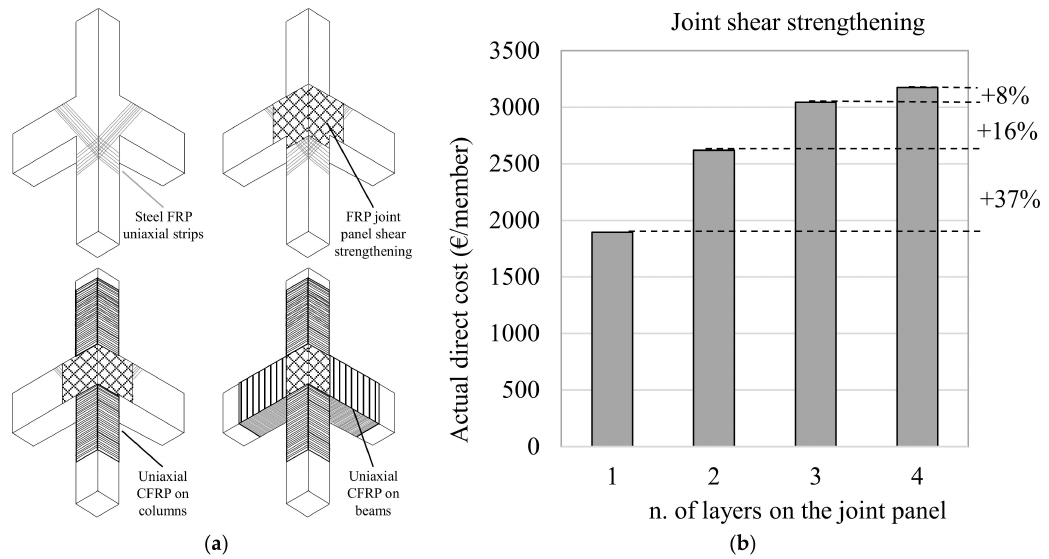
Figure 9. Fabrication steps of the joint subassembly FRP strengthening ( a ); direct cost of FRP shear strengthening of the beam-column joints as a function of the n. of layers applied to the joint panel ( b ). Table 2. Costs of FRP-strengthening interventions in a global-strengthening strategy (16 buildings).